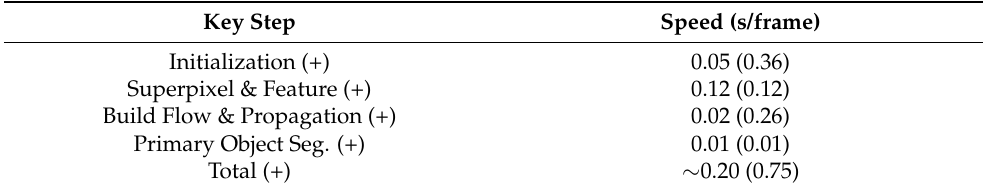
Table 6. Speed of key steps in our approach. Mark and means using